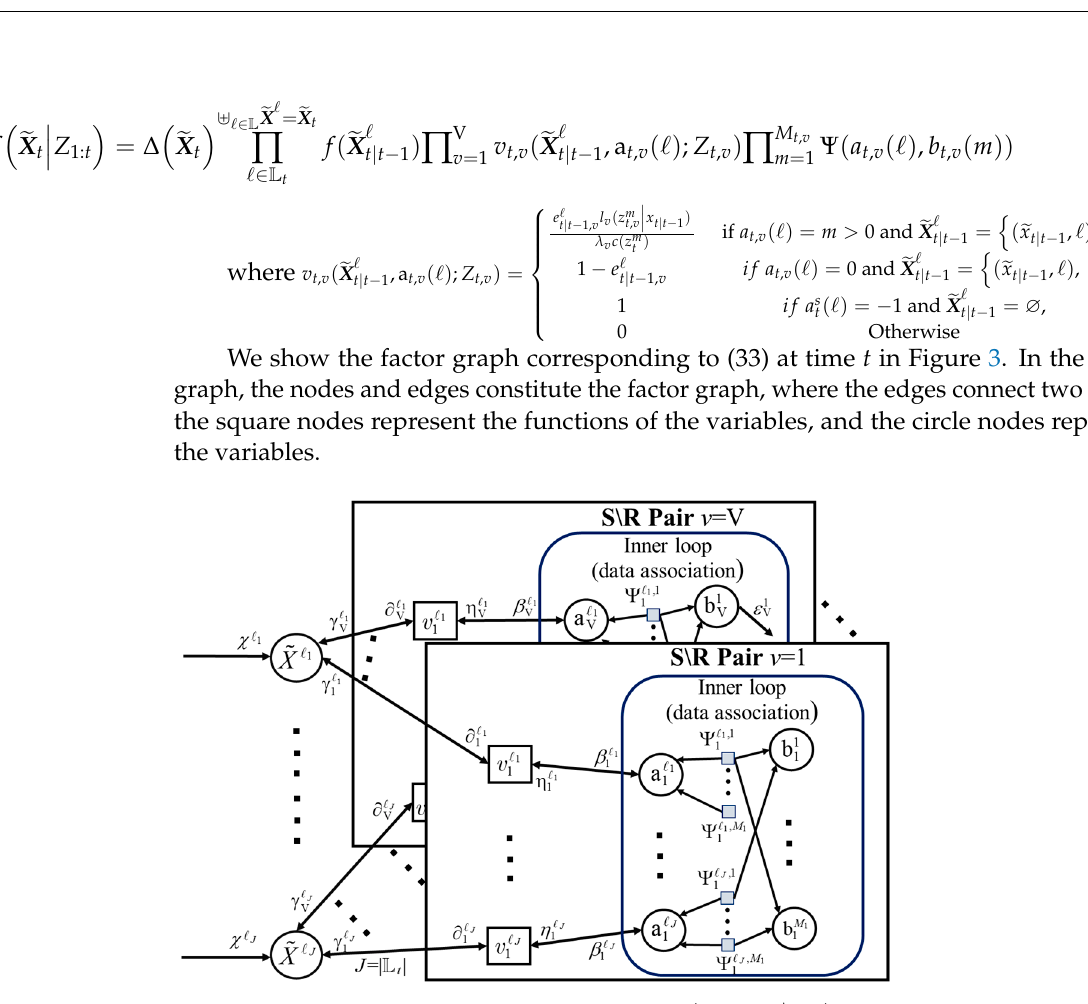
(cid:96) ) , (cid:101) X (cid:96) (cid:44) (cid:101) X (cid:96) t | t − 1